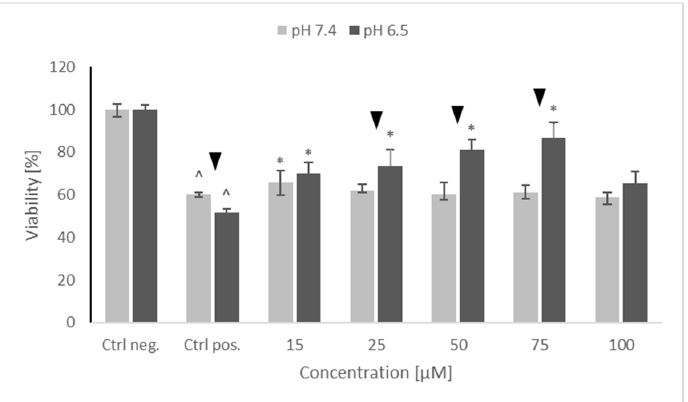
Figure 3. The protective properties of NRNPs pH against 65 µ M 6-hydroxydopamine-induced cyto- toxicity for SH-SY5Y cells at pH 7.4 and pH 6.5. Cell viability was estimated with MTT. The whiskers are lower (25%) and upper (75%) quartile ranges. ^ p ≤ 0.05, Kruskal–Wallis test vs. the negative control (Ctrl neg.; cells not treated with 6-OHDA), ▼ p ≤ 0.05, Mann–Whitney U test; differences between the different pH conditions (pH 7.4 vs. pH 6.5), * p ≤ 0.05, Kruskal–Wallis test vs. positive control (Ctrl pos.; cells treated with 6-OHDA only, without any pretreatment); n = 9.